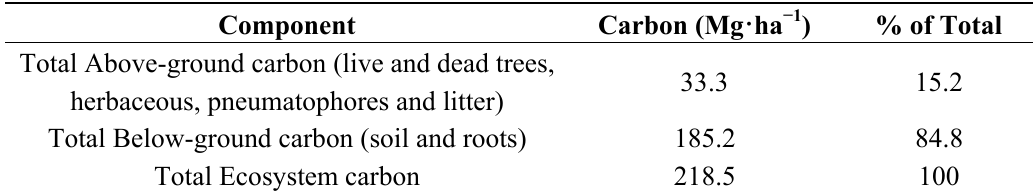
Table 4. Total Carbon stocks in the Sofala Bay mangrove